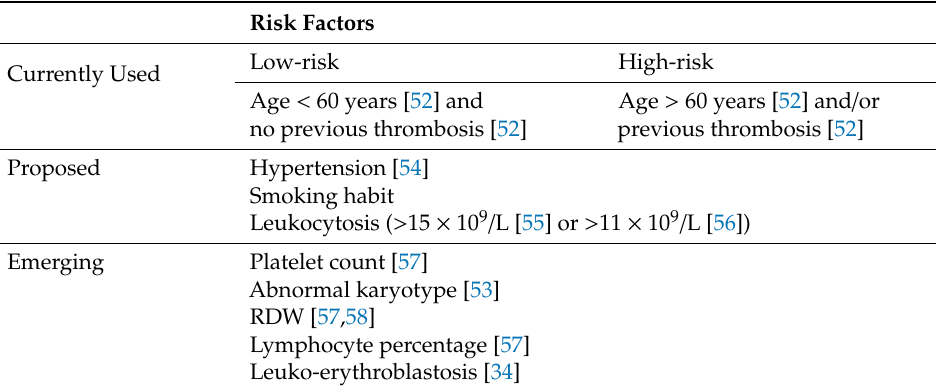
Table 2. Risk factors for thrombosis in polycythemia vera patients: currently used and proposed